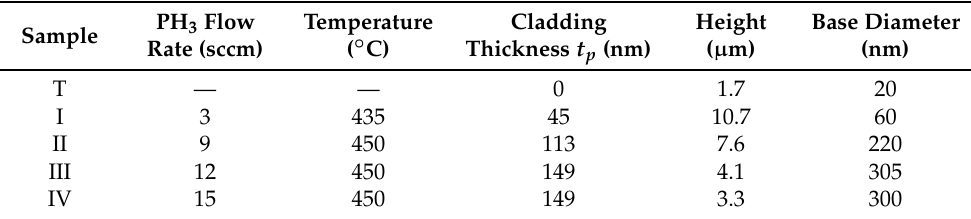
Table 1. Growth conditions used for cladding and corresponding nanowire geometries for the template nanowire T and samples I through IV in Figure 4.